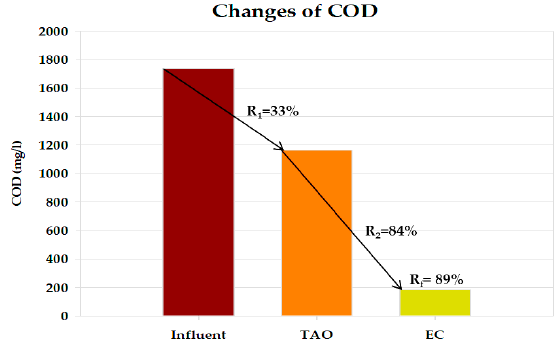
Figure 3. COD levels in the proposed TAO–EC